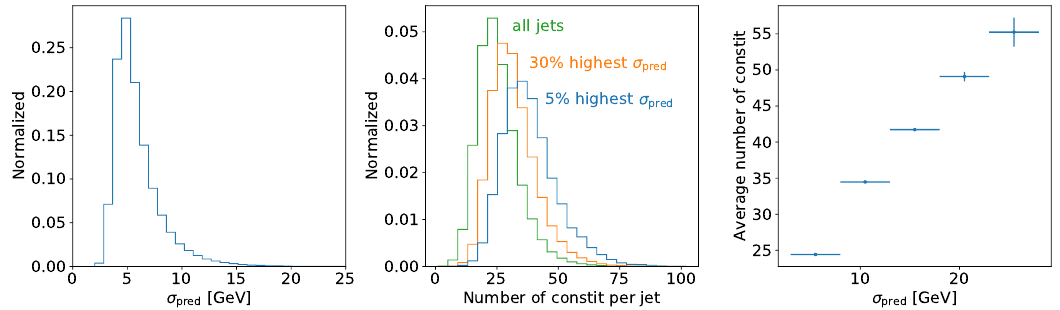
Figure 6: Left: distribution of the statistical uncertainty σ ter: number of constituents per jet for different σ constituents per jet as a function of the extracted statistical